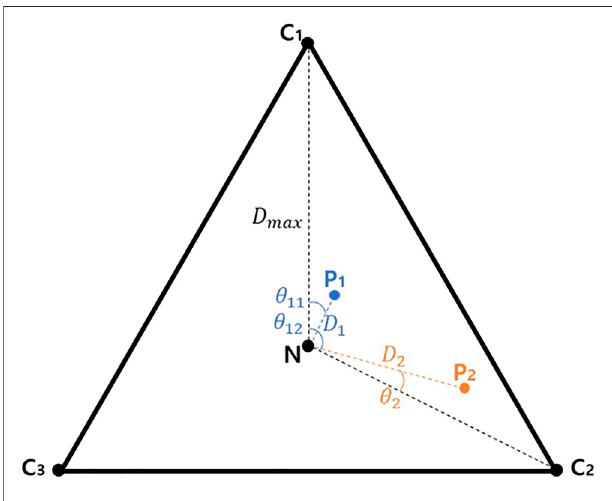
FIGURE 2 | Graphical example of neutrality index (cluster number =